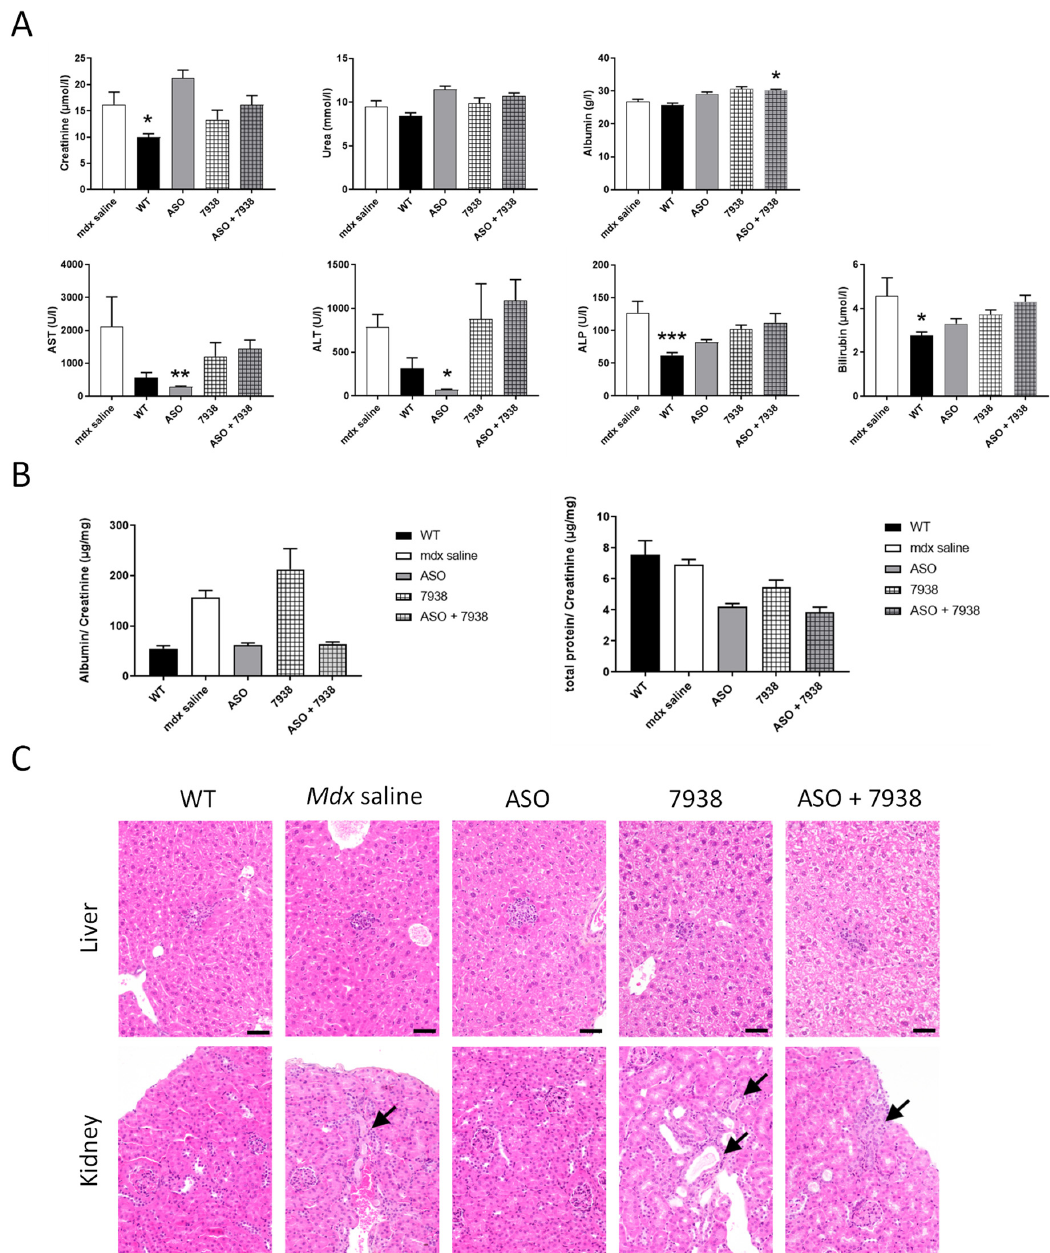
Figure 5. Safety profile of the combined UNC7938 + ASO treatment. ( A ) Quantification of general toxicity biomarkers in the serum: creatinine, urea, albumin, aspartate aminotransferase (AST), alanine aminotransferase (ALT), alkaline phosphatase (ALP), and bilirubin. Results are expressed as mean ± SEM; N = 5–8 mice per group, * p < 0.05, ** p < 0.01, *** p < 0.001 compared to mdx saline, analyzed by Kruskal-Wallis one-way ANOVA. ( B ) Quantification of total protein and albumin lev- els in the urine of WT and treated mdx mice. Urine was collected at the end of the 12-wk treatment. Results are normalized to creatinine levels and expressed as mean ± SEM; N = 5–8 mice per group; p =ns compared to mdx saline (one-way ANOVA). ( C ) Histological presentation of wild-type mice and mdx mice treated with saline, ASO, UNC7938 or ASO + 7938 for 12 weeks. In liver (upper panel), small foci of inflammatory cell infiltration were scattered in the hepatic parenchyma of all mice in every group. In kidney (lower panel), no lesions or only sporadic changes were observed except for